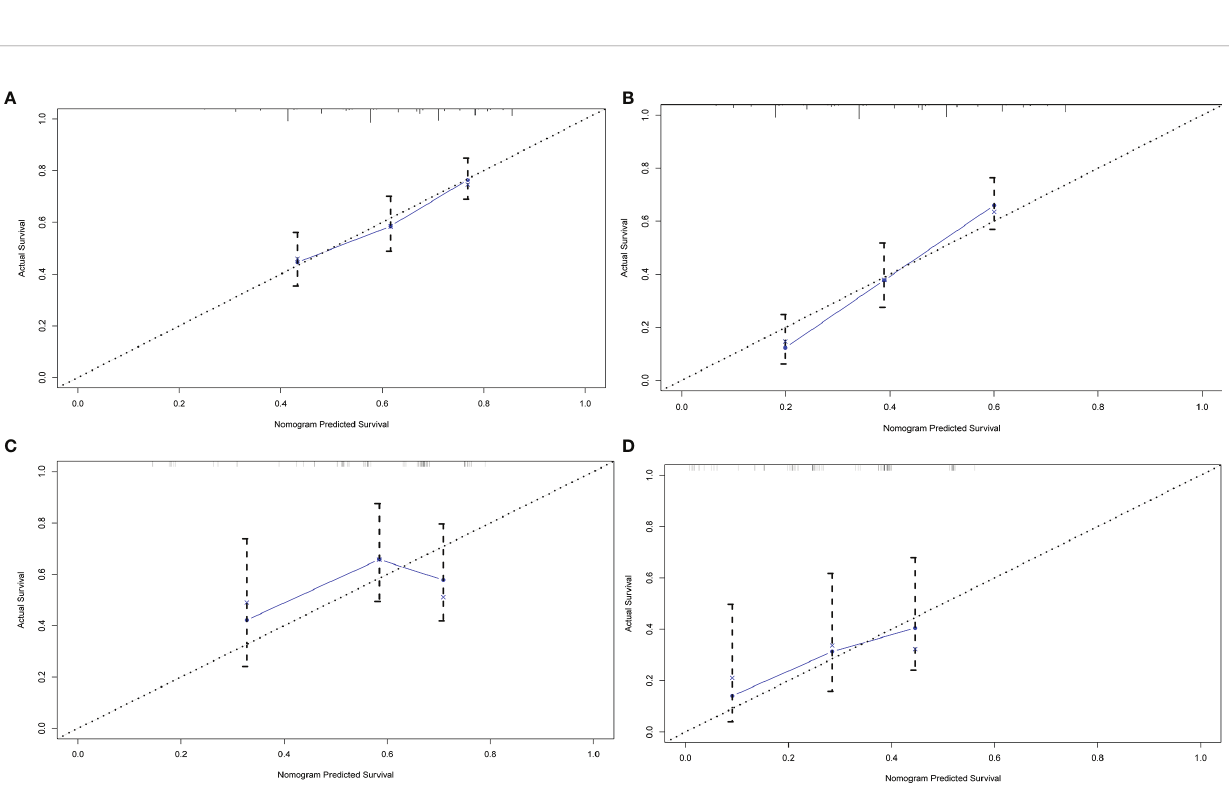
FIGURE 3 | The calibration curve of nomogram for predicting OS. (A) three years in the test group (B) fi ve years in the test group (C) three years in the validation group (D) fi ve years in the validation group. Nomogram-predicted OS is plotted on the x-axis; actual OS is plotted on the